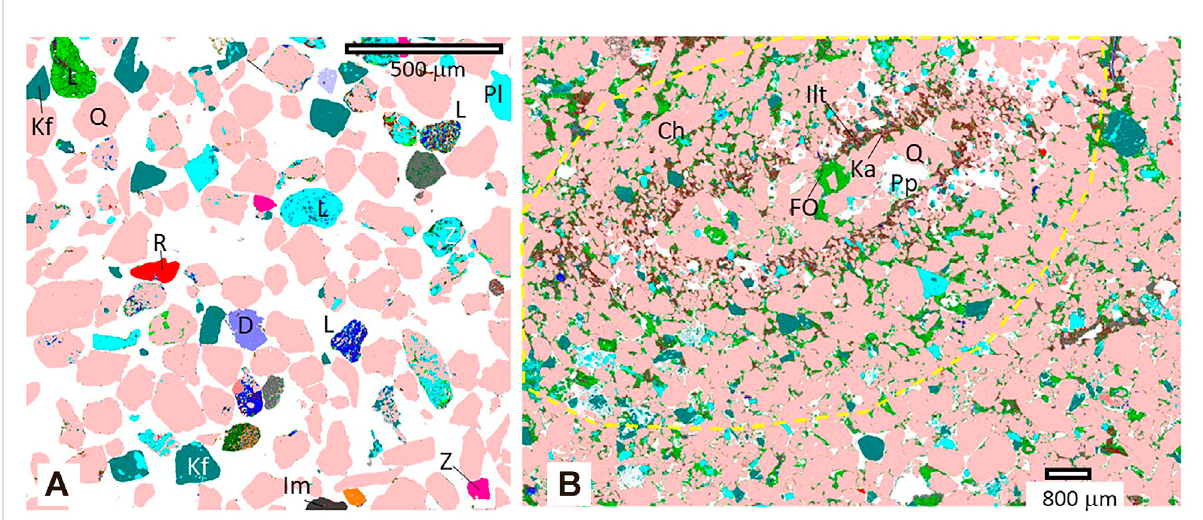
FIGURE 5 (A) Detrital sand from the modern Ravenglass Estuary in NW England (mineral colour index in Figure 3) with sediment sourced from Devonian granite and Ordovician andesites that have undergone low-grade metamorphism. The sediment is quartz (Q)-dominated but contains detrital K-feldspar (Kf), and minor plagioclase (Pl), and arich assemblage of rock fragments (L) ofboth granite and meta-andesite provenance. The sand also contains an array of heavy minerals inluding rutile (R), ilmenite (Im) and zircon (Z). (B) Detrital quartz-dominated Lower Jurassic deltaic sandstones from Halten Terrace, Norway (mineral colour index in Figure 3), with minor feldspars, locally pore- fi lling chlorite (Ch), Fe-ooids (FO) and someremainingprimaryporosity(Pp).Theyellowdashedoutlineshowstheoutlineofaburrow,possibly Skolithos (Grif fi